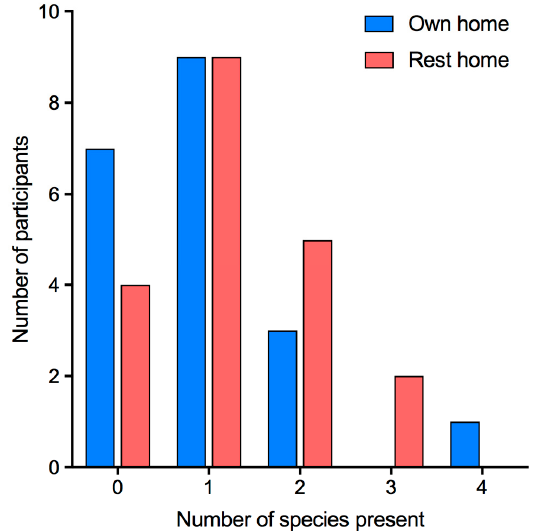
Figure 4. Number of yeast species colonizing individual participants.